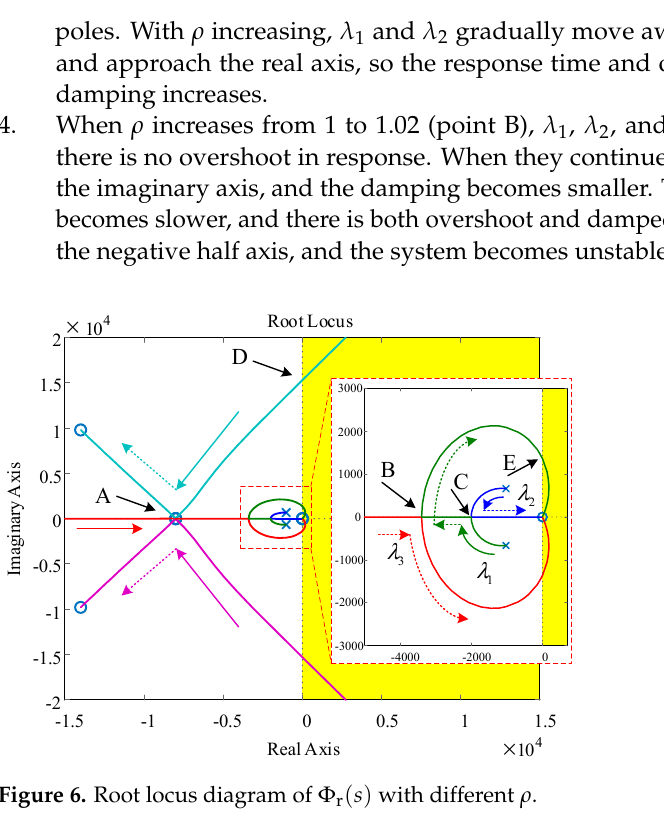
Φ ( ) s ; ( b ) Noise term d